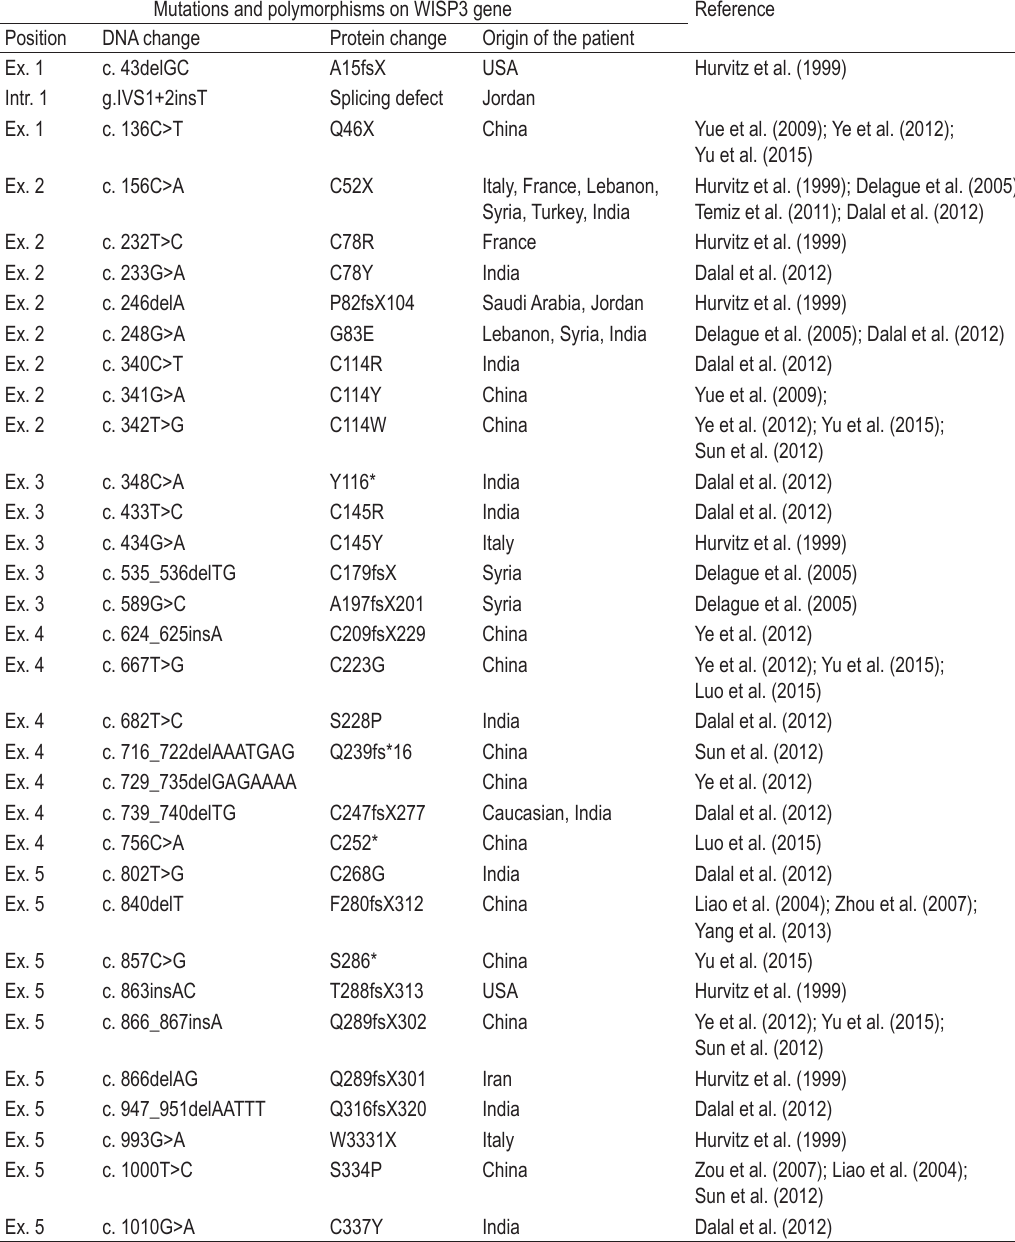
TABLE 2. Mutations observed previously in various population data sets and their effect on polypeptide chain Mutations and polymorphisms on WISP3 gene